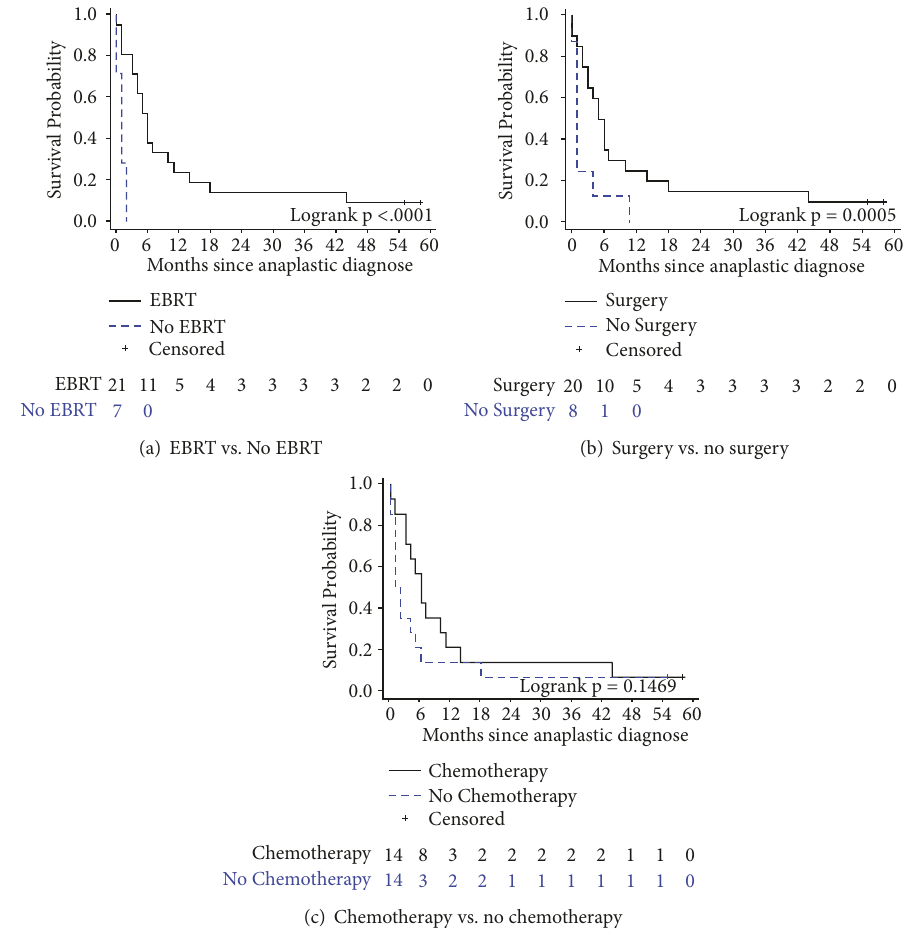
Figure 2: Overall survival for patients who underwent (a) EBRT versus no EBRT, (b) surgery versus no surgery, and (c) chemotherapyversus no